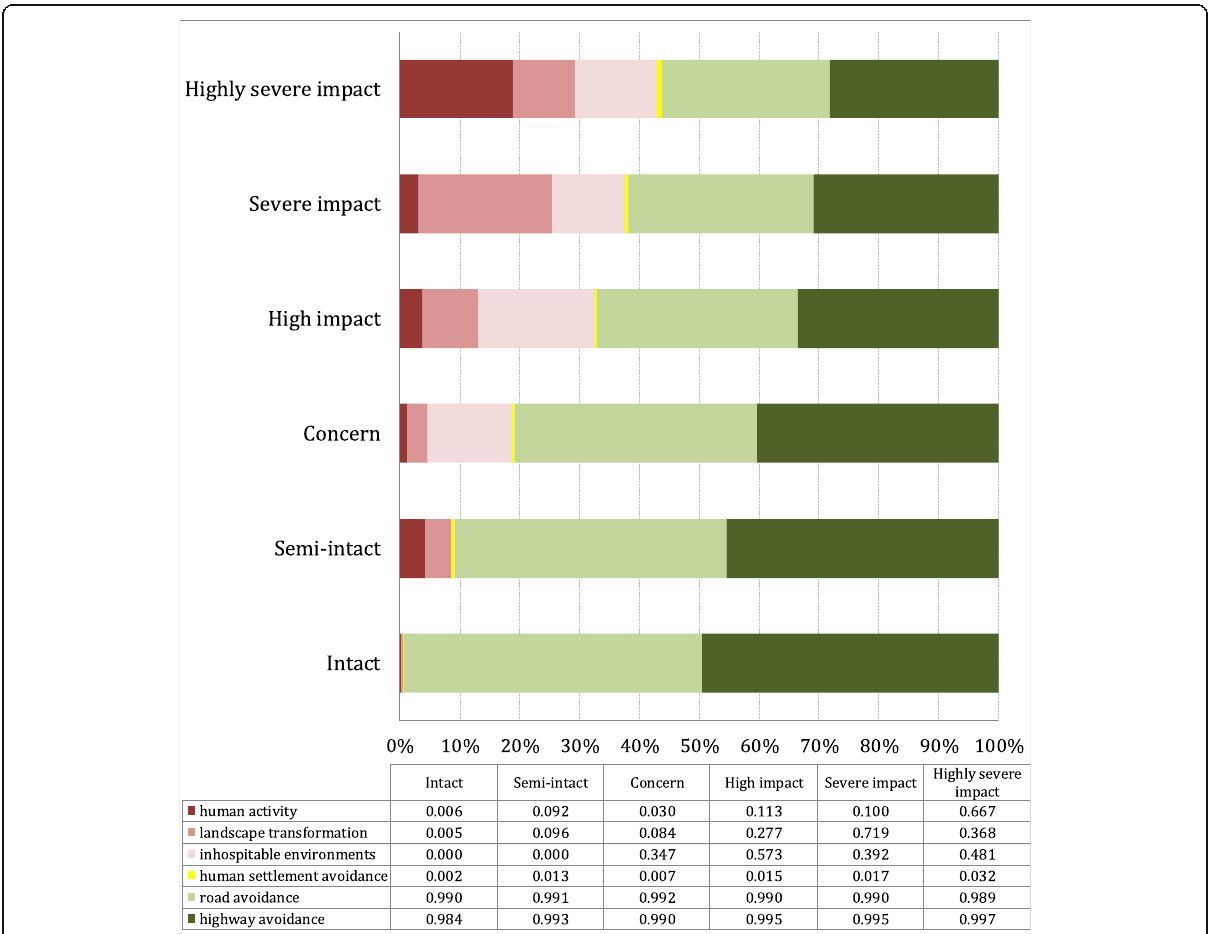
Fig. 5 The classification obtained according to the impact indicators values for the landscape of Mexico. Each class is interpreted as a function of cumulative factors of anthropogenic impact in the landscape affecting apex-predators ’ home range. Percentage values indicate the contribution of each anthropogenic impact indicator to the class